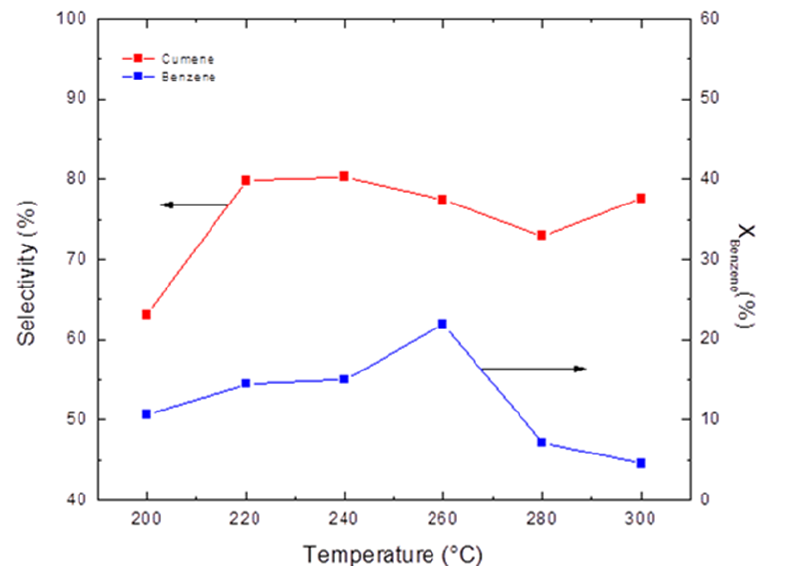
Figure 4. Activity and selectivity of the benzene alkylation reaction with propylene in a fixed-bed differential reactor across various